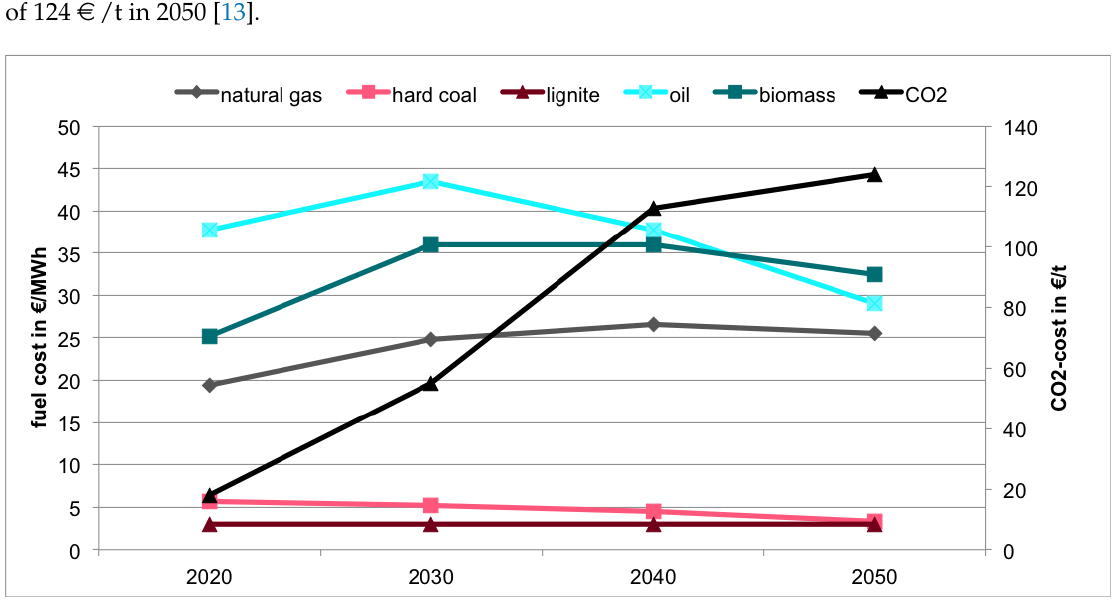
Figure 3. Underlying fuel and CO 2 cost over time, in real e